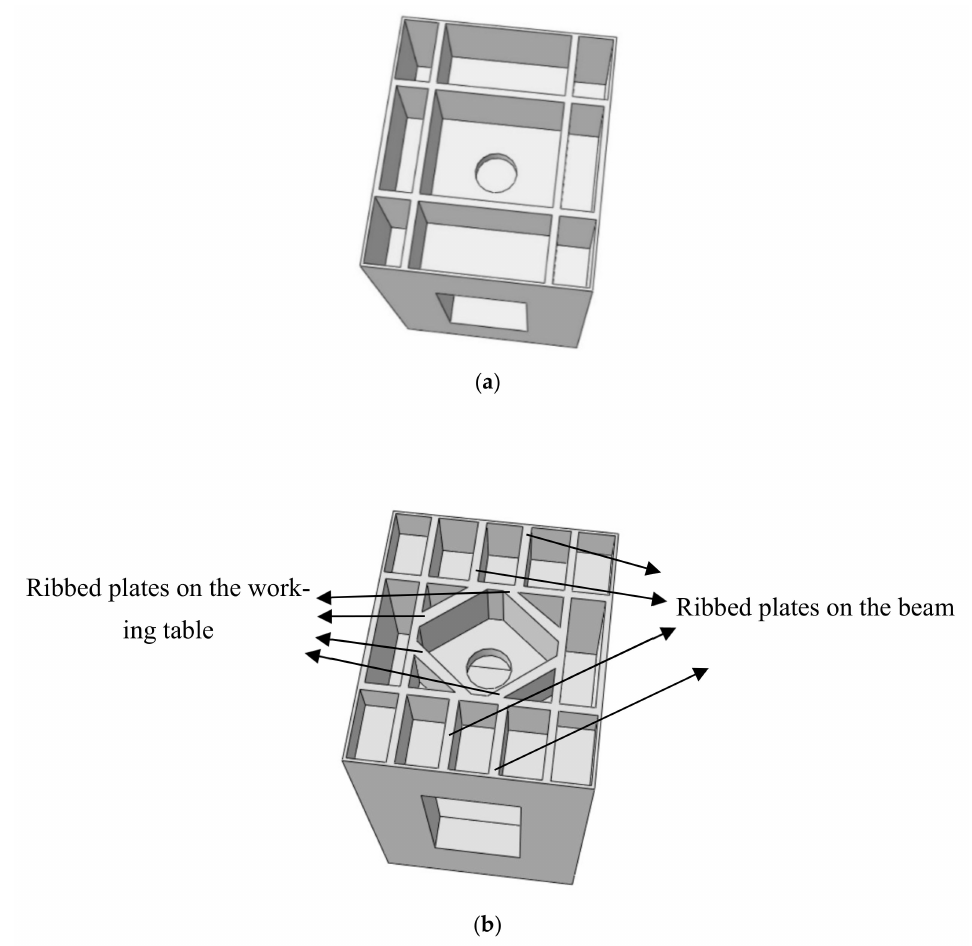
Figure 20. Initial structure ( a ) and optimized structure ( b ) of the COF machine.